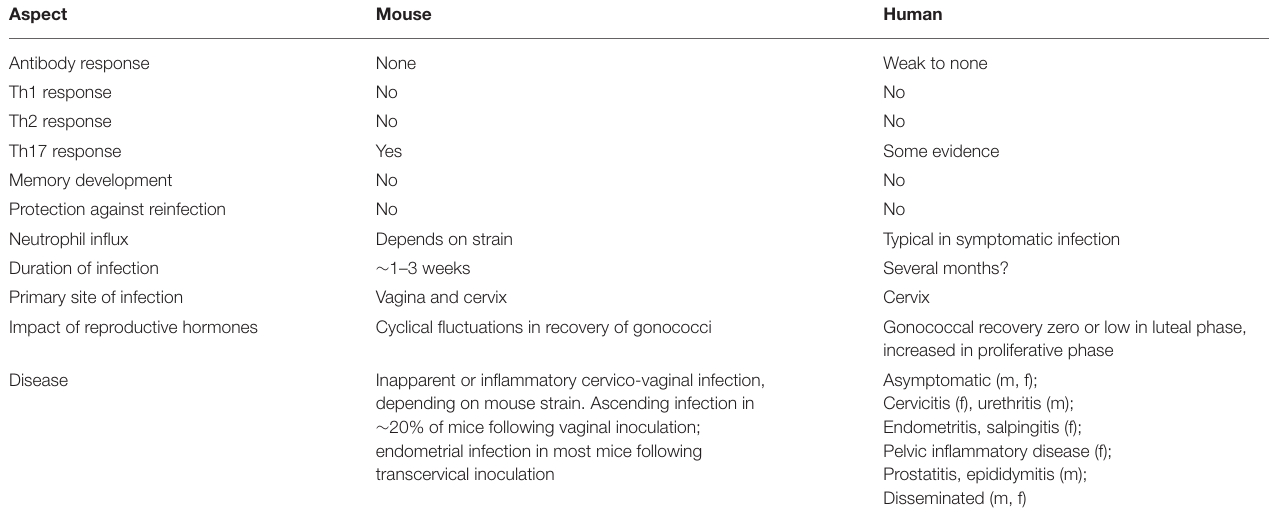
TABLE 1 | Similarities and differences in gonococcal infection between mice* and humans. Aspect